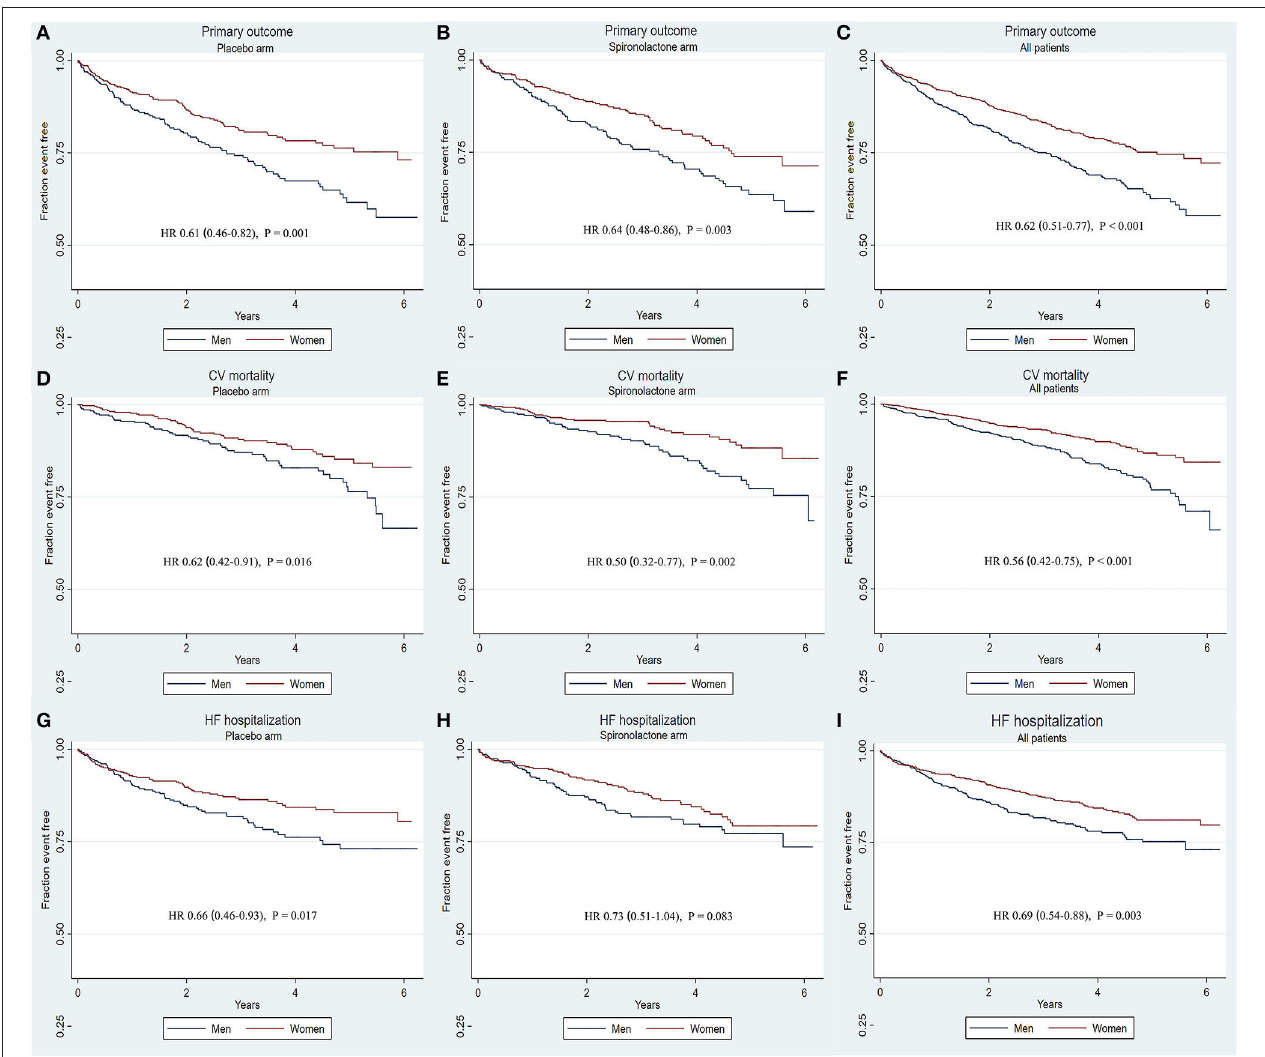
FIGURE 1 | Kaplana–Meier survival curves for primary outcomes and components stratified by sex according to treatment. There was a significant association between sex and the primary outcome, CV mortality in either placebo arm or spironolactone arm. Women had a significantly lower rate of all the primary outcomes in all patients. (A–C) Primary outcome in placebo arm, spironolactone arm, all patients; (D–F) CV mortality in placebo arm, spironolactone arm, all patients; (G–I) HF-related hospitalization in placebo arm, spironolactone arm, all patients. CV, cardiovascular diseases; HF, heart failure; HR, hazard